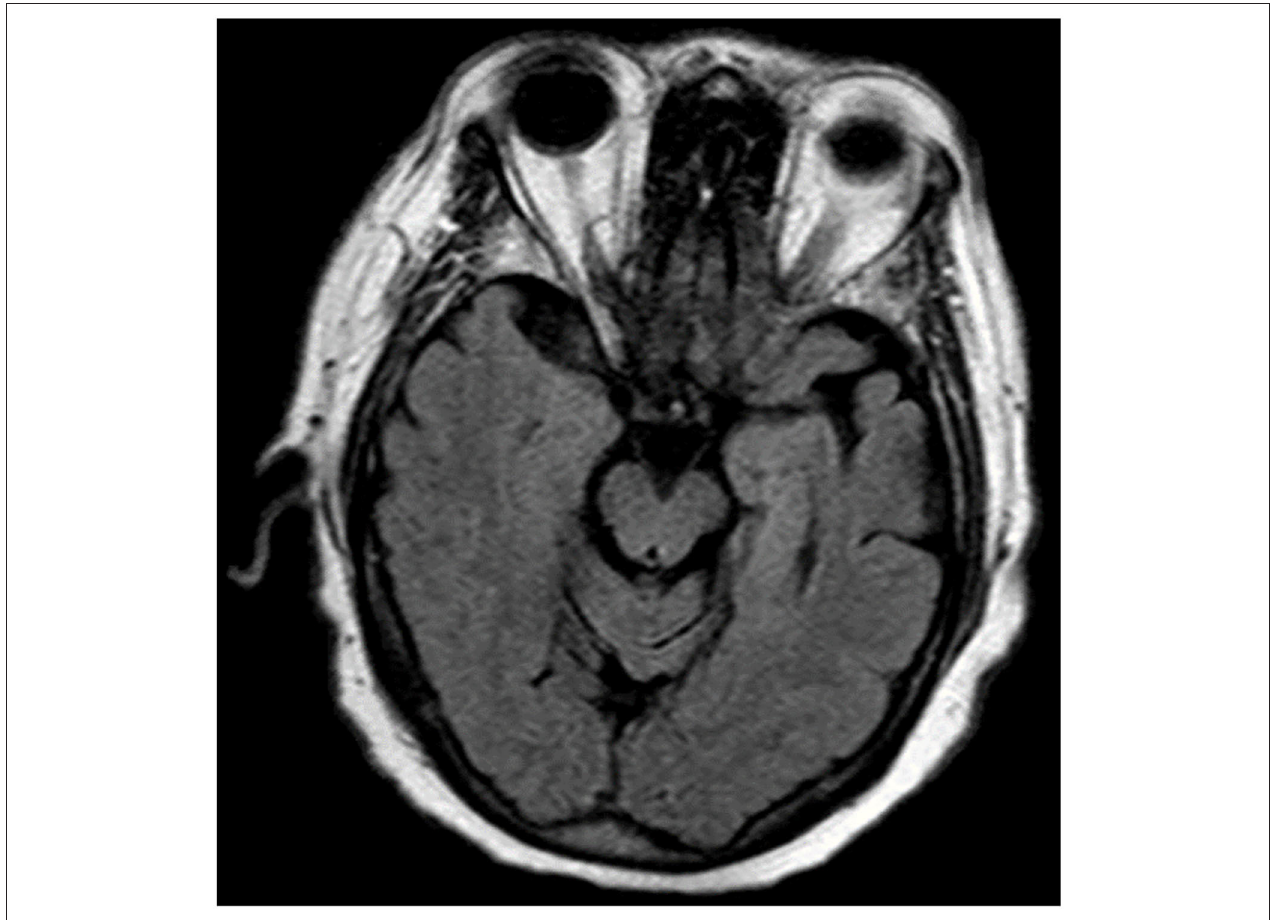
FIGURE 1 | The patient’s magnetic resonance imaging revealed low brain volumes in the anterior temporal lobe and frontal